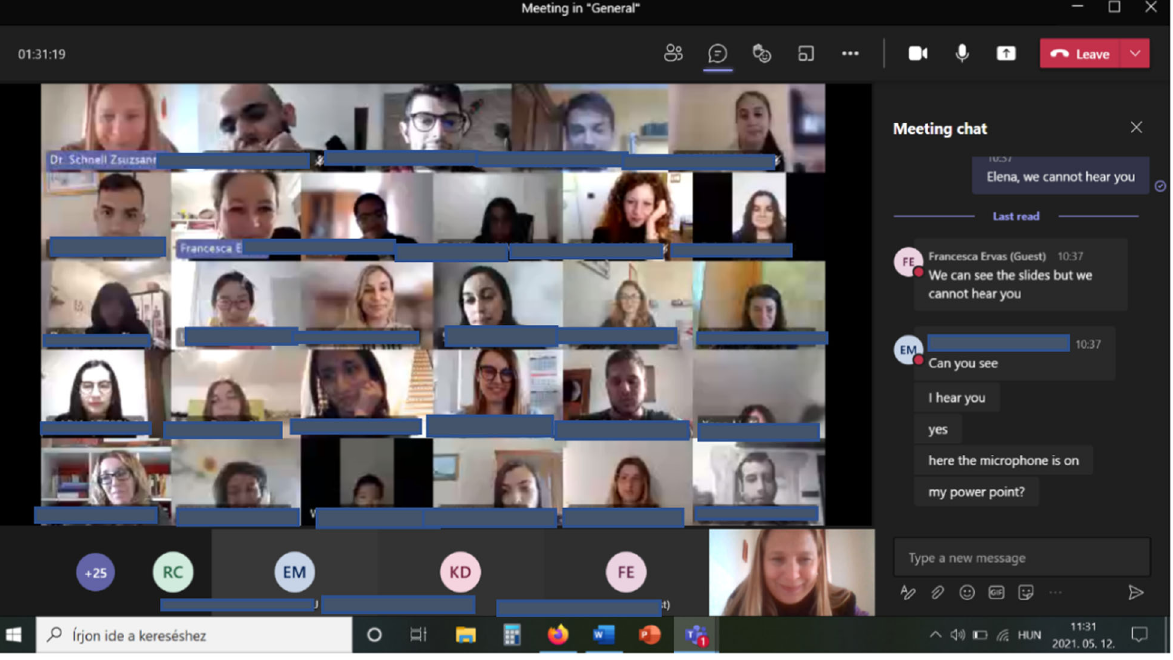
Fig. 3 EDUC course participants in online